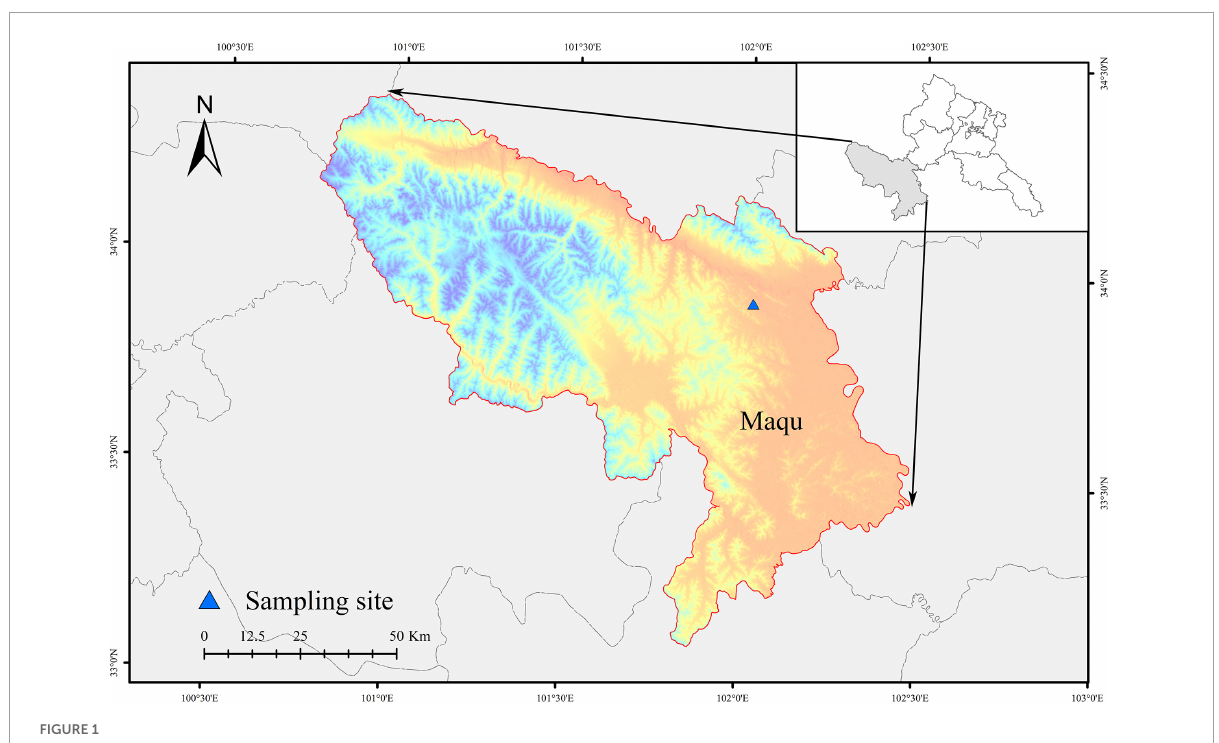
FIGURE1 Locations of the study site on the Qinghai-Tibetan